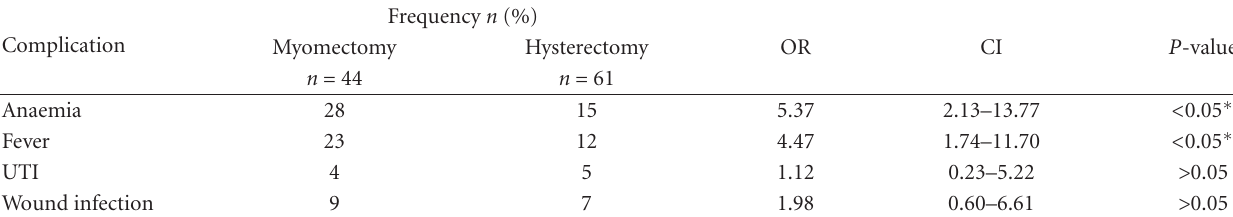
Table 4: Postoperative